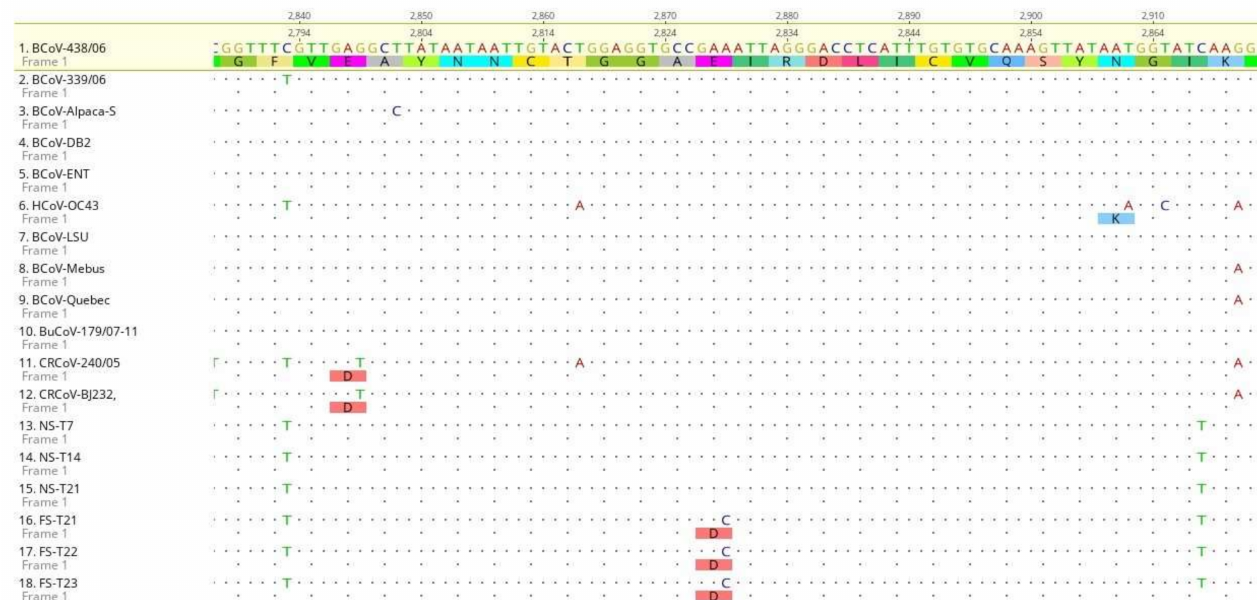
Figure 6. Antibodies to BCoV. Serum IgG and nasal IgAs antibodies detected with IF assay and serum antibodies detected with SN test.